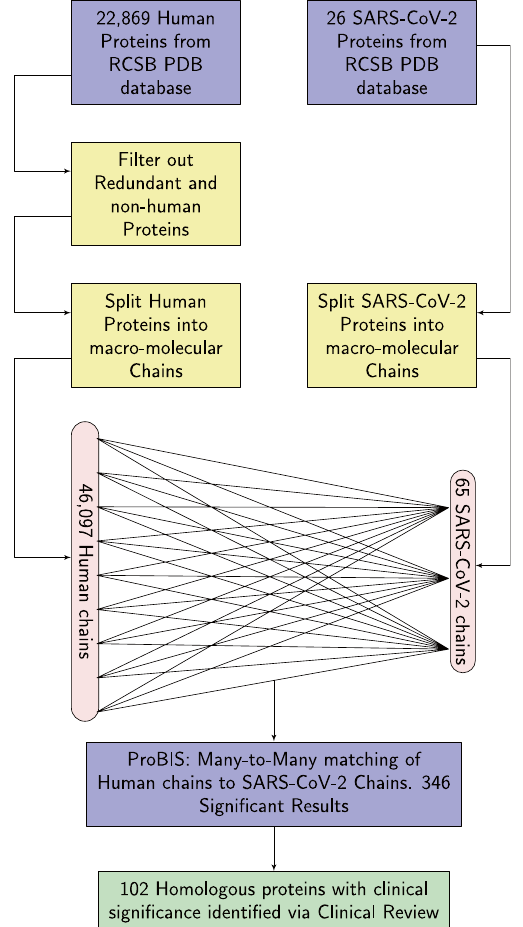
Figure 1. Structural homology identification workflow. A description of our workflow for identifying the steps for identifying homologous protein structures. First, obtain PDB files human and SARS-CoV-2 Wuhan strain proteins. Second, filter out redundant and non-endogenous human proteins. Third, split all proteins into macro- molecular chains. Fourth, find matches between SARS-CoV-2 chains and human chains. Fifth, identify which chains found in step 4, belong to proteins which could have clinical indications related to